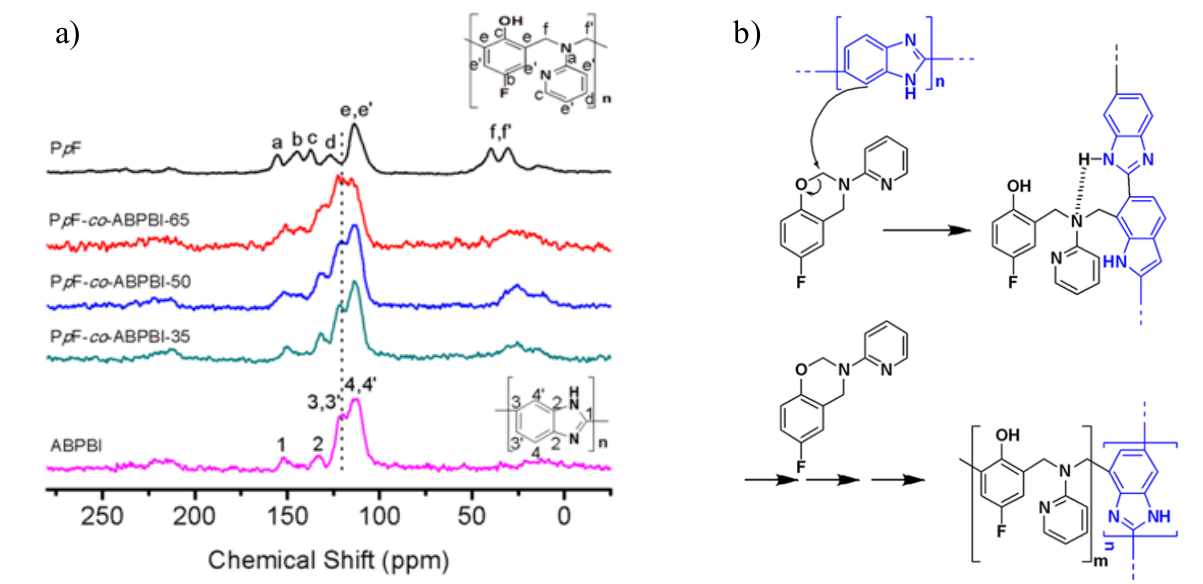
Figure 5. ( a ) Solid-state cross-polarization/magic angle spinning 13 C NMR spectra; and ( b ) possible reaction between p F and ABPBI forming the cross-linked P p F- co -ABPBIs